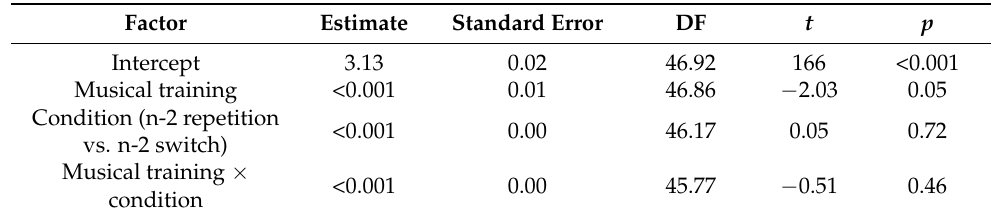
Table 4. Estimates for mixed model on n-2 repetition costs (dependent variable: reaction times).